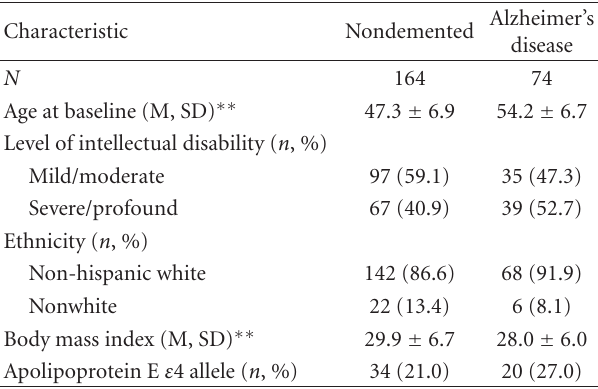
Table 1: Demographic